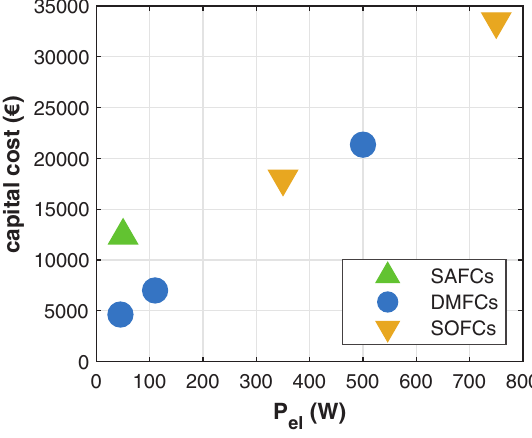
Figure 13. Capital costs of FCs.